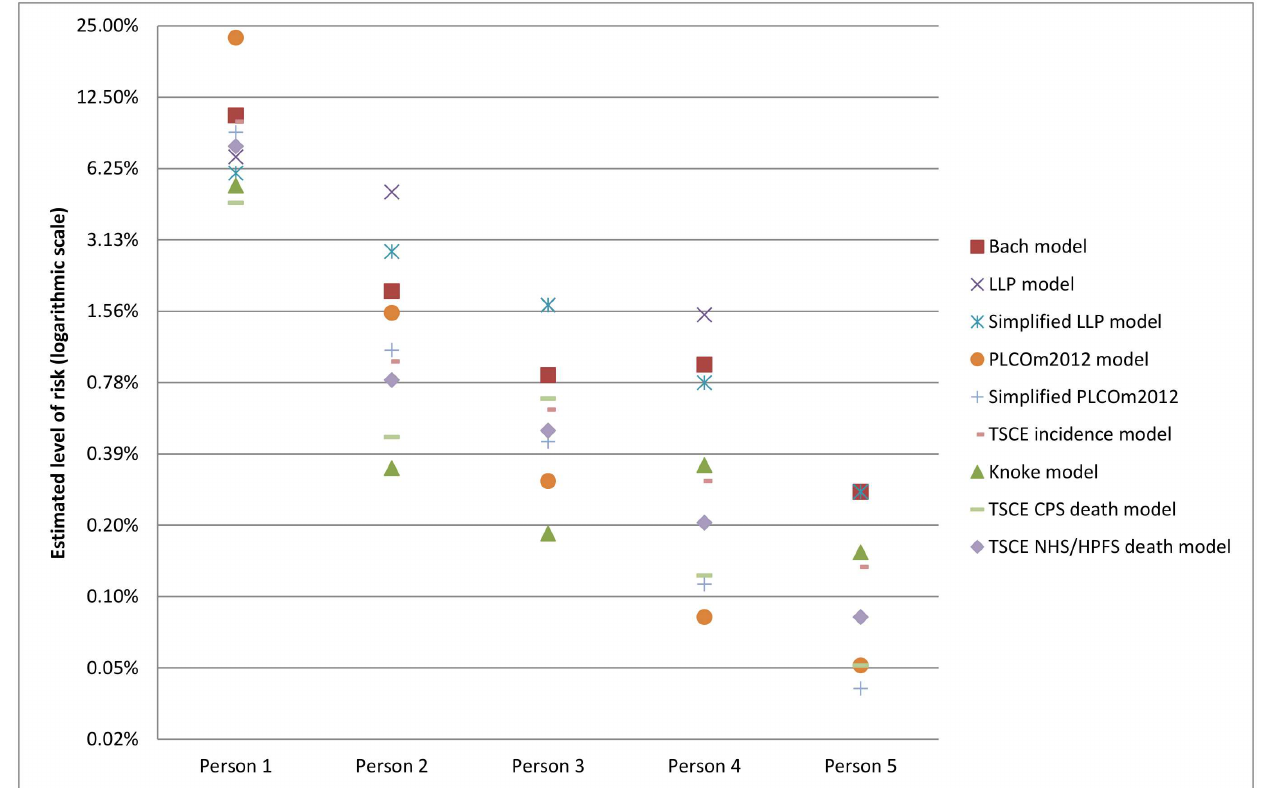
Fig 1. Examples of projected absolute risk for individuals with different risk factor profiles by model. Person 1: 70-y-old, high-school- graduatedwhite male, current smoker, who smoked 30 cigarettes per day for 55 y, has a BMI of 28 kg/m 2 , has COPD, no asbestos exposure, no personalhistory of cancer, no personalhistory of pneumonia, but has a family history of lung cancer (relative was diagnosed at age > 60 y). Person 2: 63-y-old,college-graduated black woman, former smoker who quit 10 y ago, who smoked 15 cigarettes per day for 40 y, has a BMI of 25 kg/m 2 , does not have COPD, no asbestos exposure, no personalhistory of cancer, has a personal history of pneumonia,and no family history of lung cancer. Person 3: 65-y-oldAsian male with some collegeeducation, former smoker who quit 14 y ago, who smoked 10 cigarettes per day for 30 y, has a BMI of 24 kg/m 2 , does not have COPD, has asbestos exposure, no personalhistory of cancer, no personalhistory of pneumonia, and no family history of lung cancer. Person 4: 58-y-old, post-graduate-educated Hispanic woman, current smoker, who smoked 5 cigarettes per day for 38 y, has a BMI of 22 kg/m 2 , does not have COPD, no asbestos exposure, has a personal history of cancer, no personal history of pneumonia, and no family history of lung cancer. Person 5: 50-y-old, college-educated white woman, current smoker, who smoked 5